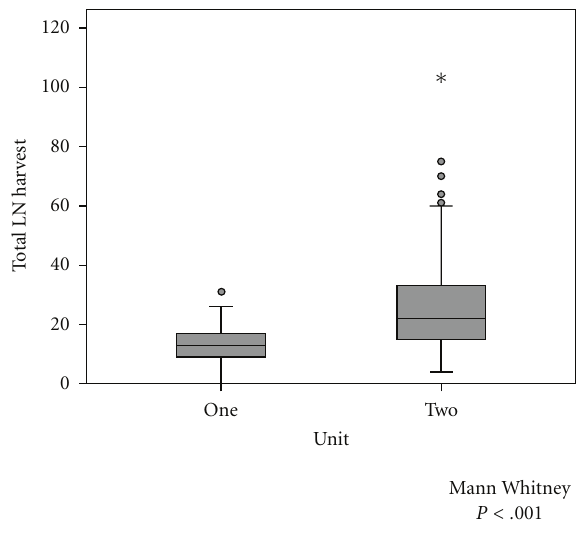
Figure 1: Boxplots of LN harvest at the two units. Grey boxes represent the interquartile range, black horizontal line within the grey box the median LN harvest, the and whiskers the range with circles representing statistical